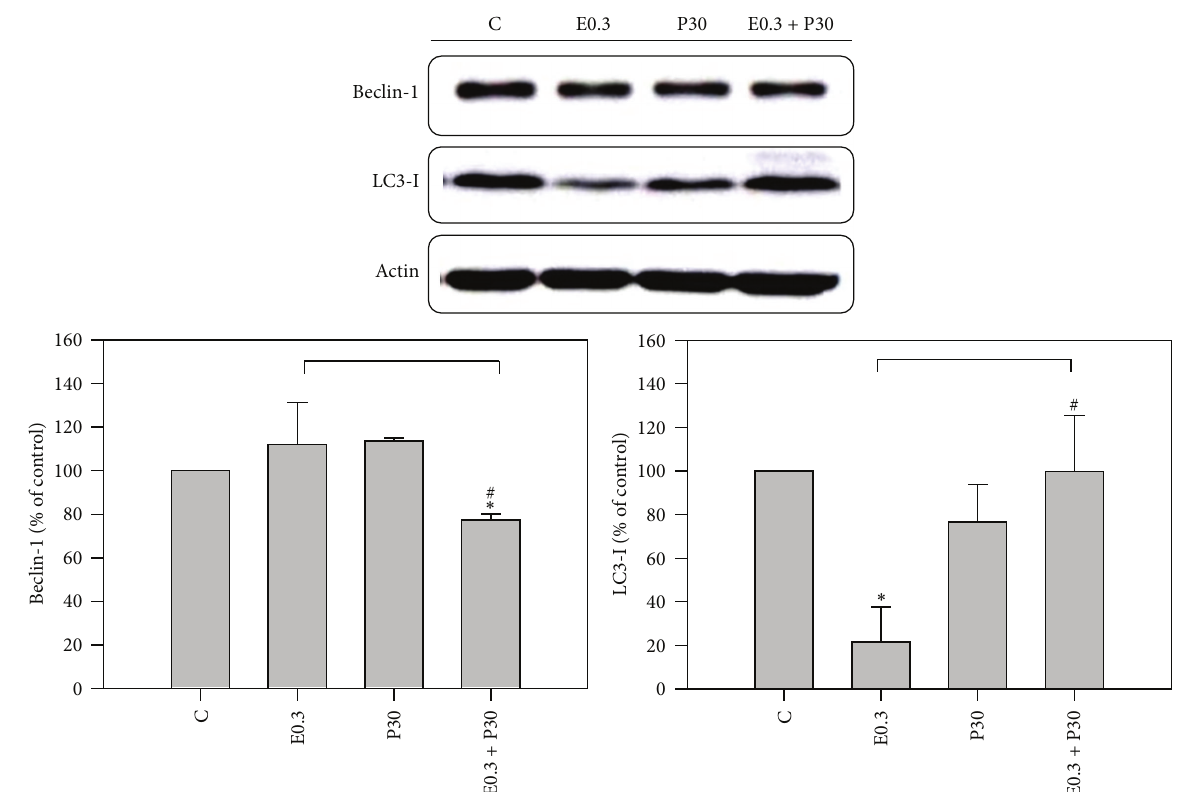
Figure 5: Western blotting shows Beclin-1 and LC3-I expressions in HA22T/VGH cells after epirubicin and/or progesterone treatment for 24 h. Results are expressed as the mean ± standard deviation (S.D.) for three separate experiments. C: untreated cells, E0.3: 0.3 𝜇 M epirubicin, and P30: 30 𝜇 M progesterone. ∗ 𝑃 < 0.05 compared to the untreated controls. # 𝑃 < 0.05 compared to epirubicin-treated